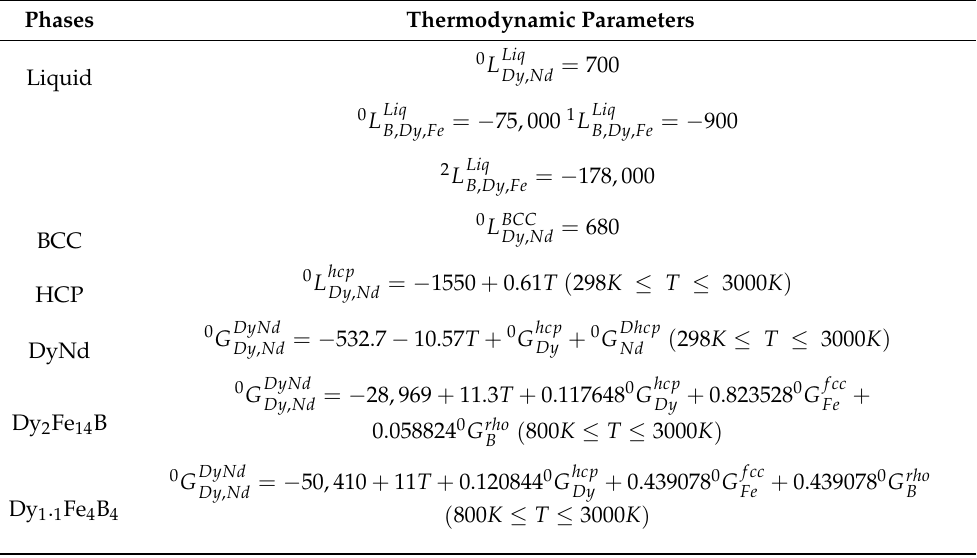
Table 1. Optimized model parameters for the Nd–Dy–Fe–B system. L denotes the interaction parameters for the excess molar Gibbs energy, and G denotes the molar Gibbs